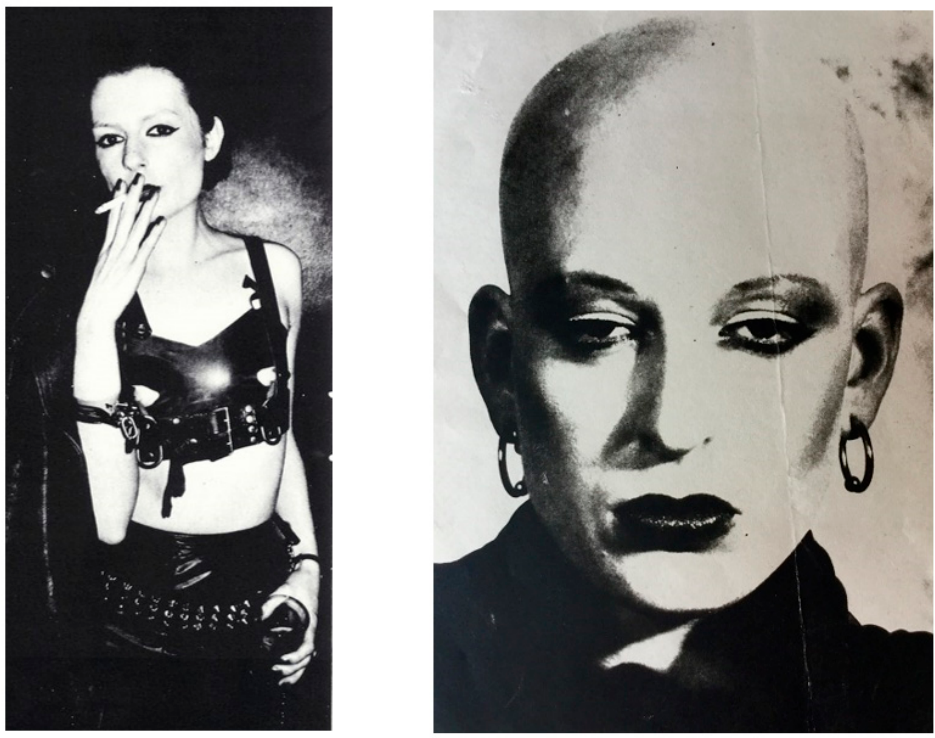
Figure 2. ( Left ) Jill Westwood, 1984. Photo by Derek Ridgers. ( Right ) Diana “Chrystal Belle Scrodd” Rogerson, c. 1981.